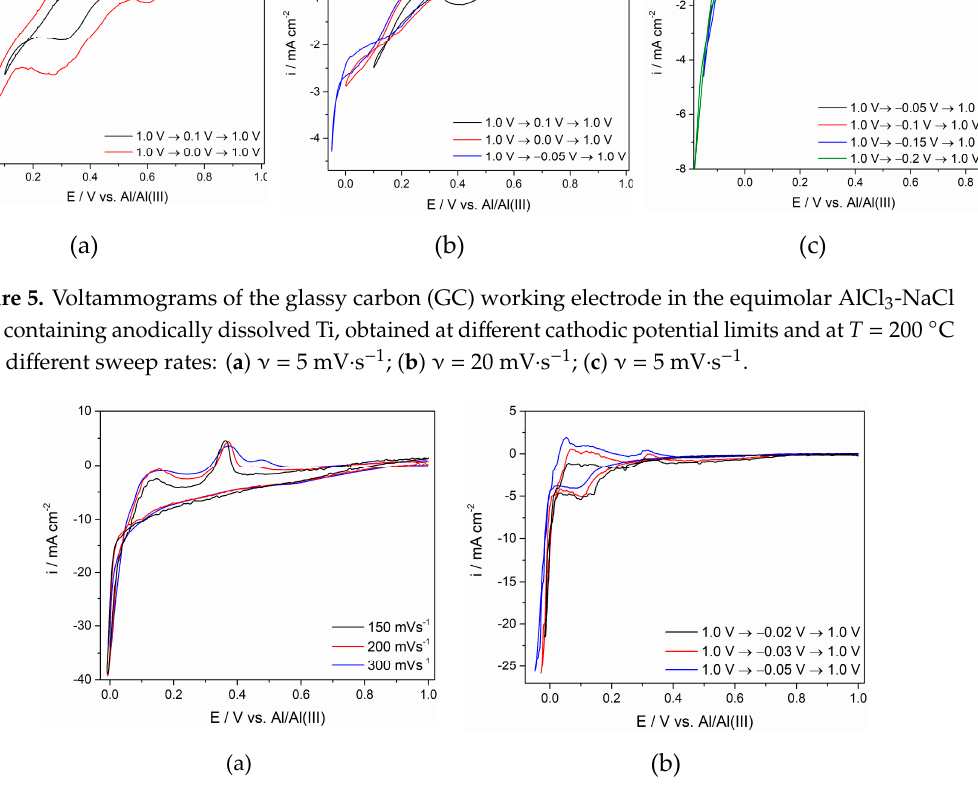
Figure 6. Voltammograms obtained on the GC working electrode in the equimolar AlCl 3 -NaCl melt containing anodically dissolved Ti at T = 300 °C on different conditions: ( a ) potential change: E I = 1.000 V to E F = 0.0 V with different sweep rates; ( b ) at different cathodic potential limits at a constant sweep rate ν of 50 mV·s − 1 .